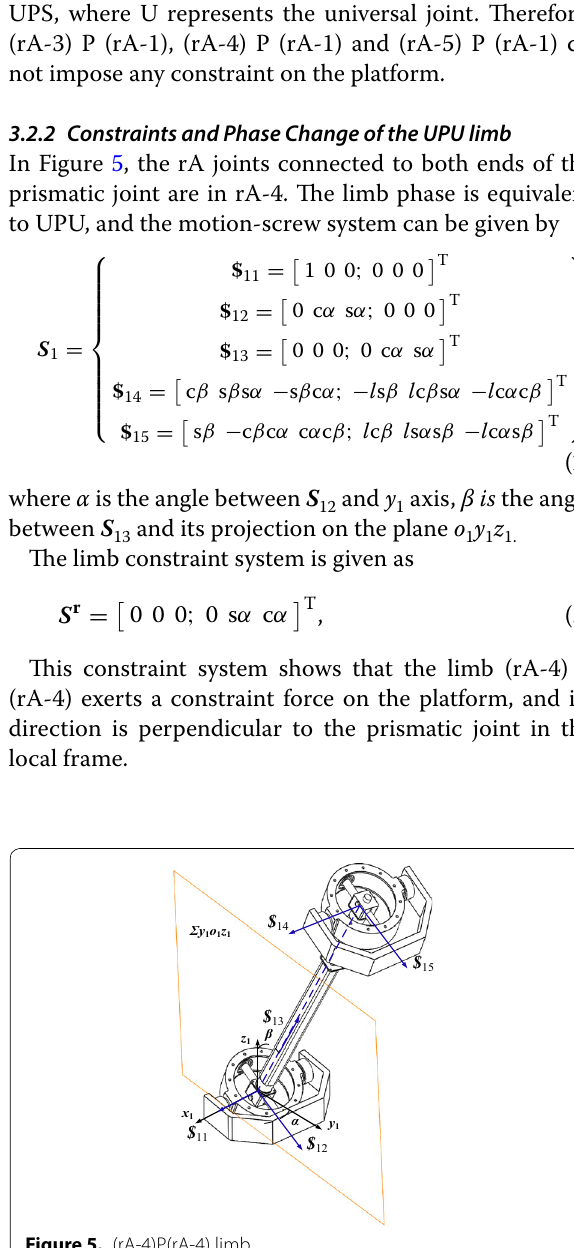
Figure 5. (rA-4)P(rA-4) limb